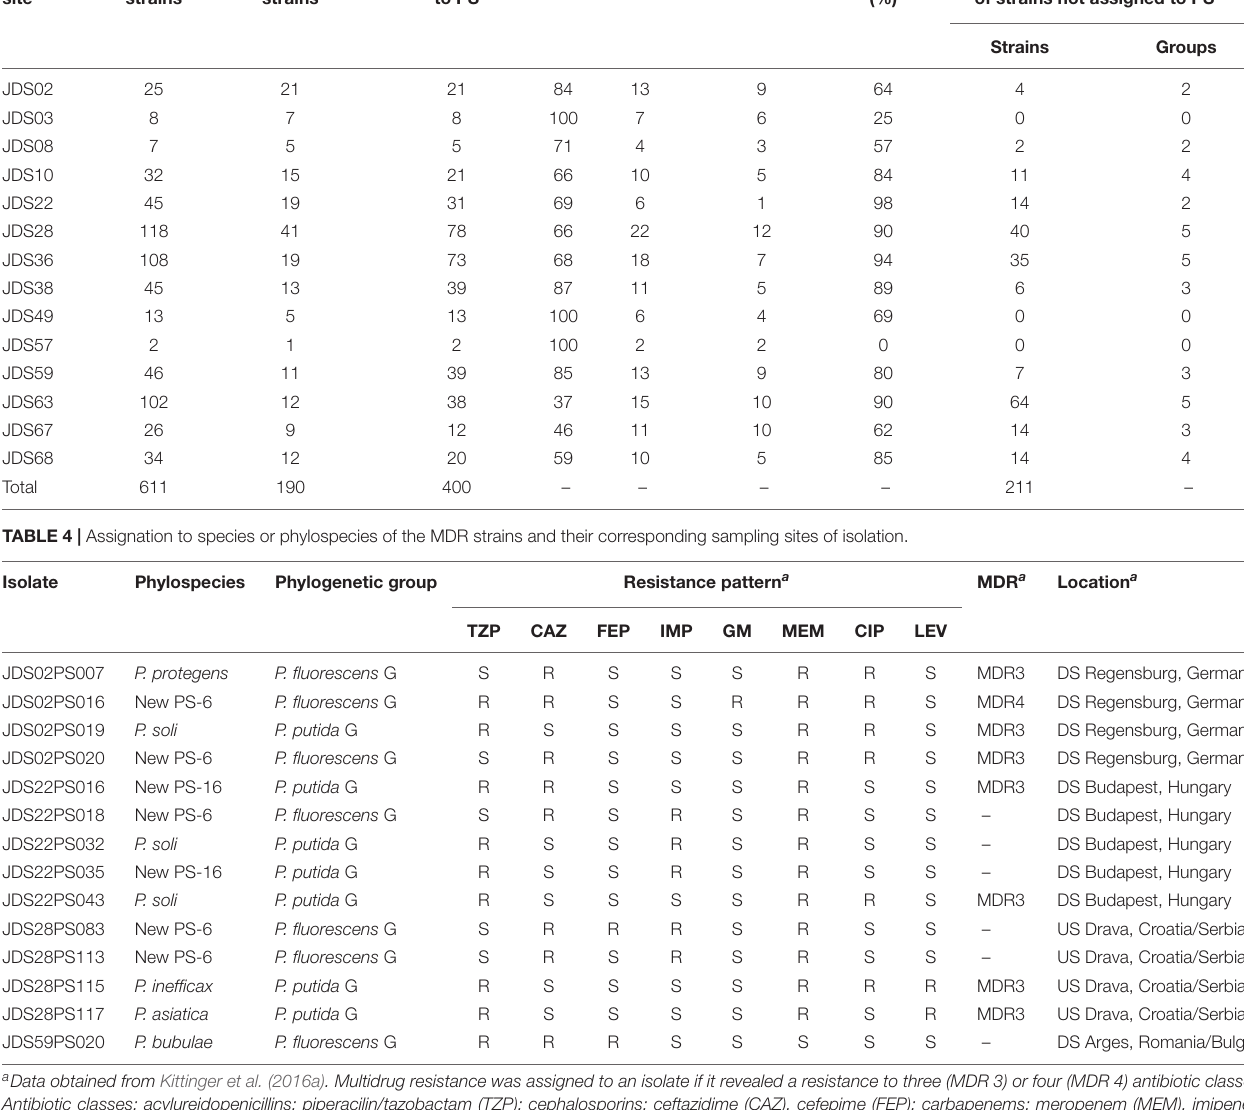
TABLE 3 | Phylospecies richness and coverage index for each sampling site. Sampling site